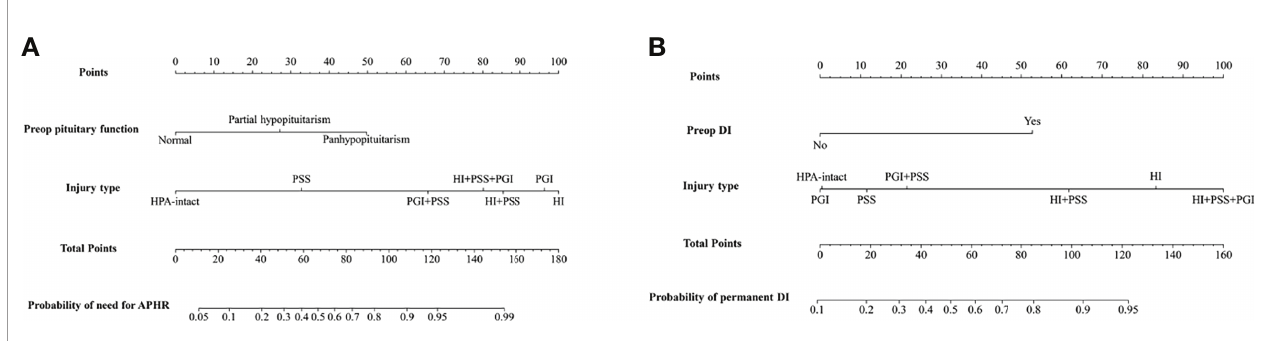
FIGURE 3 | Nomograms to predict the rate of need for anterior pituitary hormone replacement 1 year after surgery (A) and permanent diabetes insipidus (B) in patients with craniopharyngioma. HPA, hypothalamus – pituitary axis; PSS, pituitary stalk sacri fi ce; PGI+PSS, pituitary gland injury combined with pituitary stalk